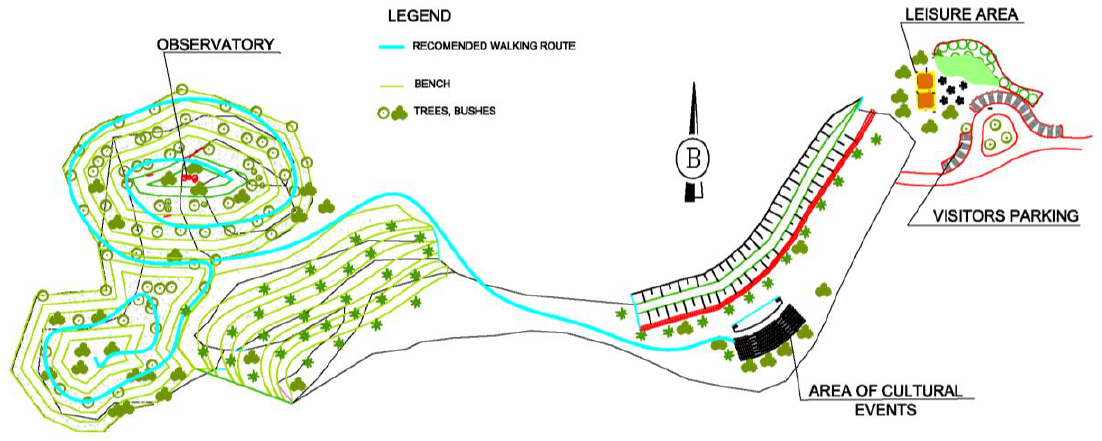
Figure 8. Restoration proposals for the quarry in Asvestades according to the alternative scenario A4, scale 1:2000.